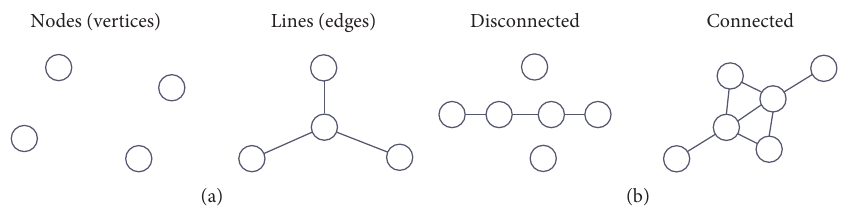
Figure 1: Schematic representation of nodes and lines (a) and connectivity